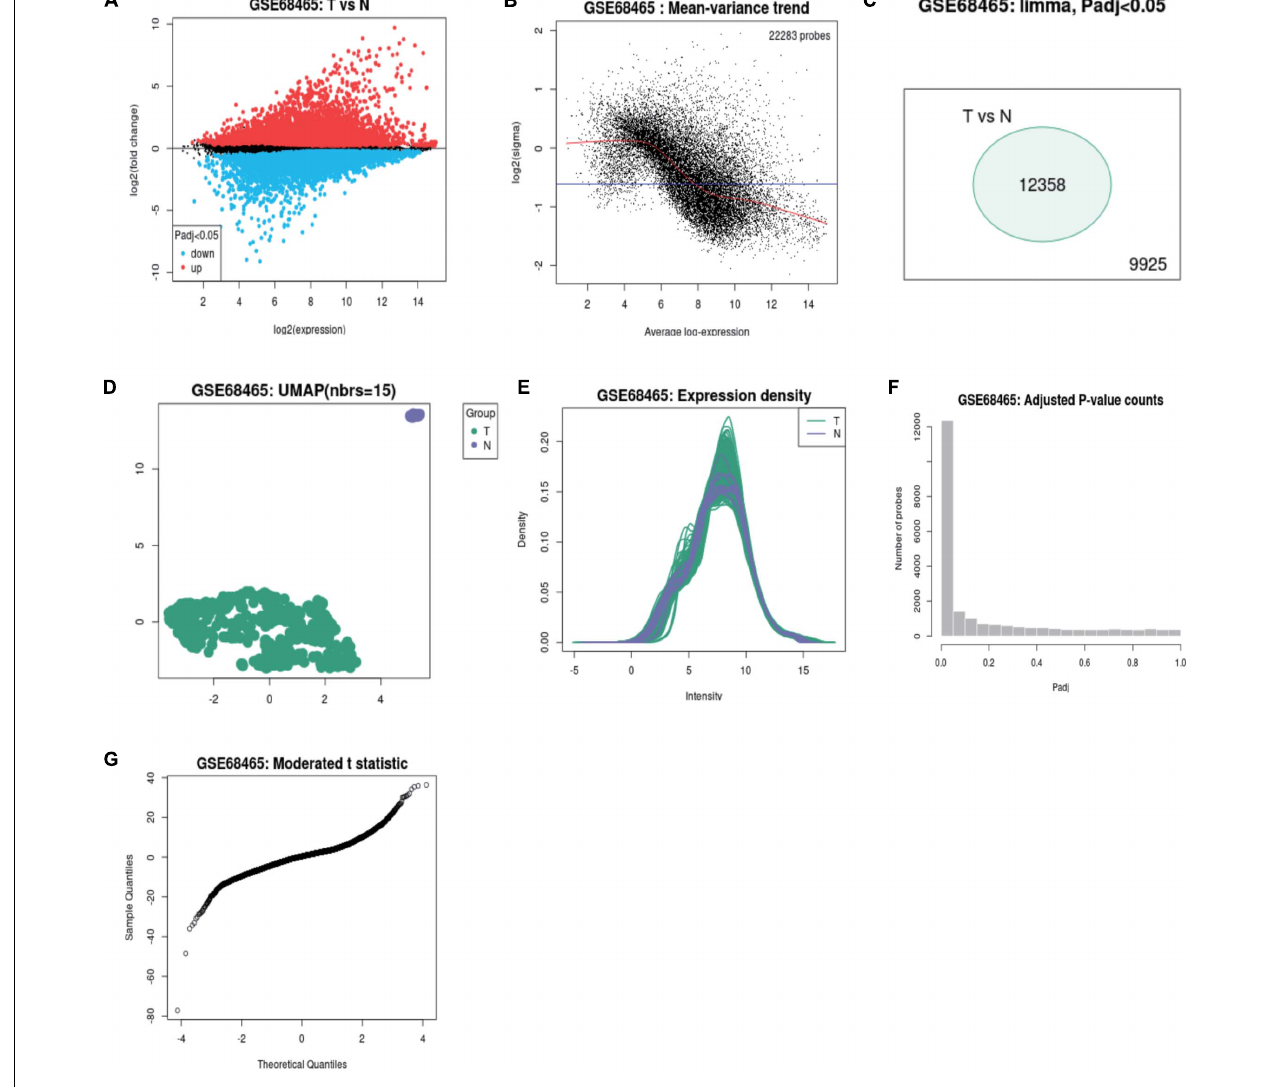
Frontiers in Cell and Developmental Biology |